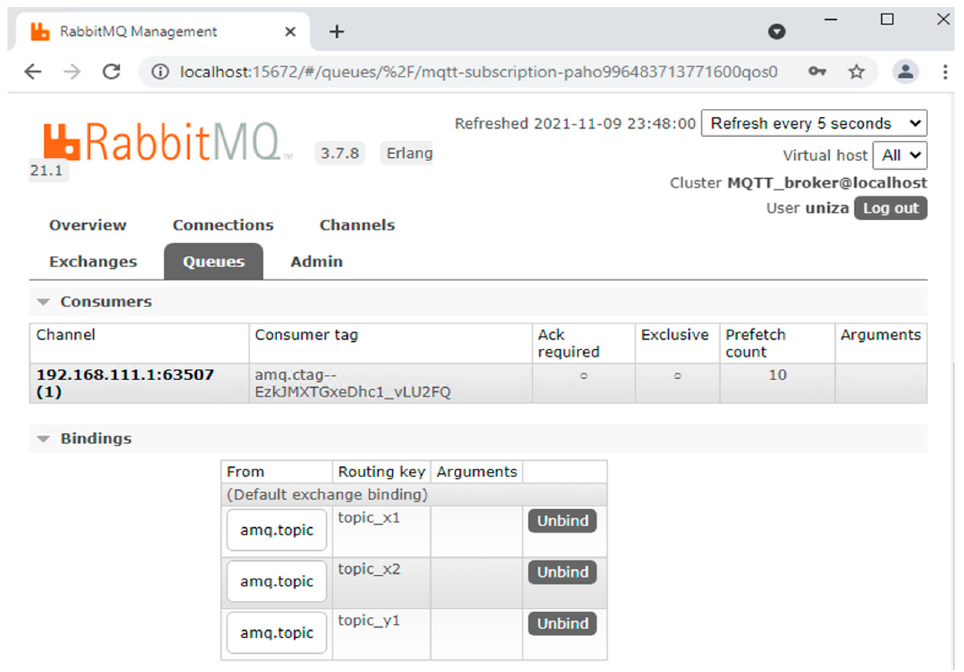
Figure 10. RabbitMQ queue setting for virtual redundant sensor as a consumer.